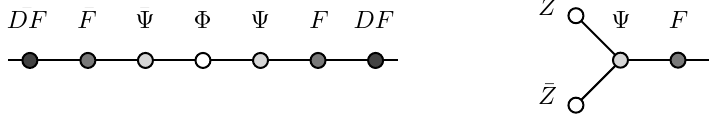
Figure 2 . The (cid:13)ux tube excitations of the N = 4 and N = 6 theory can be aligned along the nodes of two in(cid:12)nite Dynkin diagrams of A and D type, respectively. The coloring goes along with the mass E ( p = 0) of the excitation | the heavier the darker. On the left panel, we have at the center the 6 scalar (cid:12)elds of the SYM theory surrounded by the 4 + 4 twist 1 gaugino (cid:12)elds (light grey blobs). The darkest grey blobs stand for the gluonic modes: they carry no R charge but come in two in(cid:12)nite families of bound states (of positive and negative helicities, respectively) with twist a = 1 ; 2 ; : : : . The right panel shows the corresponding picture for the ABJM theory. There is a single in(cid:12)nite tail of gluons F a =1 ; 2 ;::: in that case. The light grey blob on the fork is for the fermions (cid:9) AB in the 6 of SU(4). The lightest modes are on the fork’s extremities: they are twist 1 = 2 spinons Z A and anti-spinons (cid:22) Z A , in the 4 and (cid:22) 4 of SU(4),